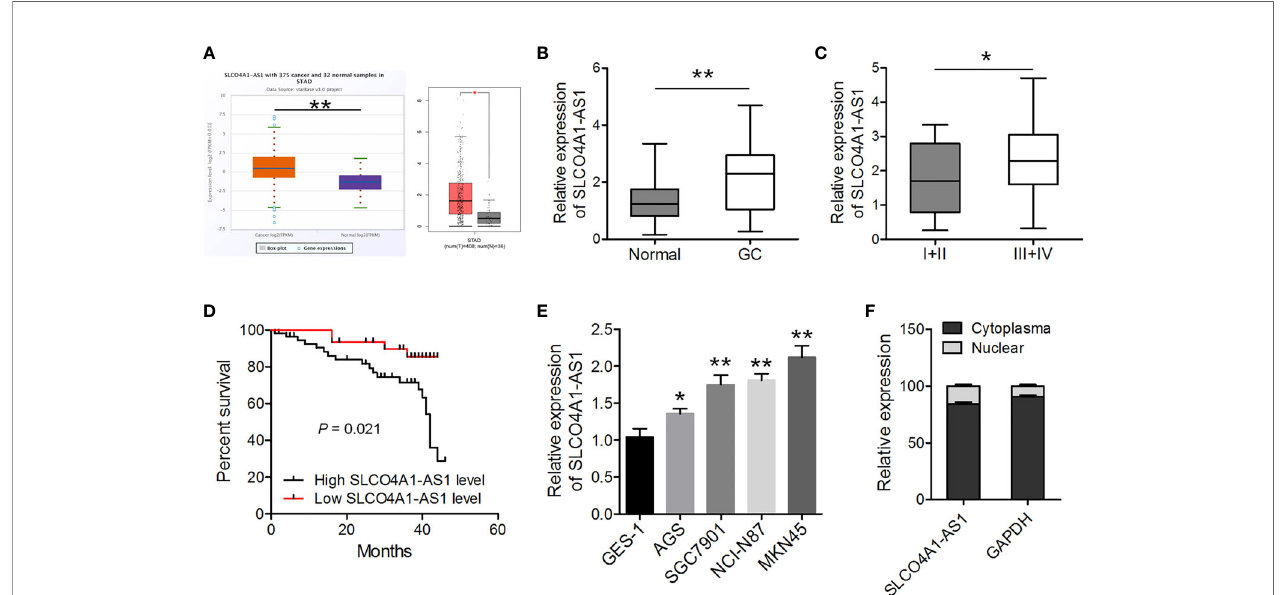
FIGURE 1 | SLCO4A1-AS1 expression increased in gastric cancer (GC) tissues and cell lines. (A) SLCO4A1-AS1 expression in GC and normal samples in the ENCORI and GEPIA databases. (B) SLCO4A1-AS1 expression was measured using RT-qPCR in GC and paired normal tissues from 88 patients with GC. (C) SLCO4A1-AS1 expression in association with clinical stages of gastric tumor samples. (D) The overall survival curves of the 88 patients with GC with high SLCO4A1-AS1 and low SLCO4A1-AS1 expressions. (E) RT-qPCR analysis for SLCO4A1-AS1 levels in GC and GES-1 cells. (F) RT-qPCR data indicating the abundance of SLCO4A1-AS1 in either the cytoplasm or nucleus of AGS cells. GAPDH was used as internal control for cytoplasmic RNA. * P < 0.05, ** P < 0.01.